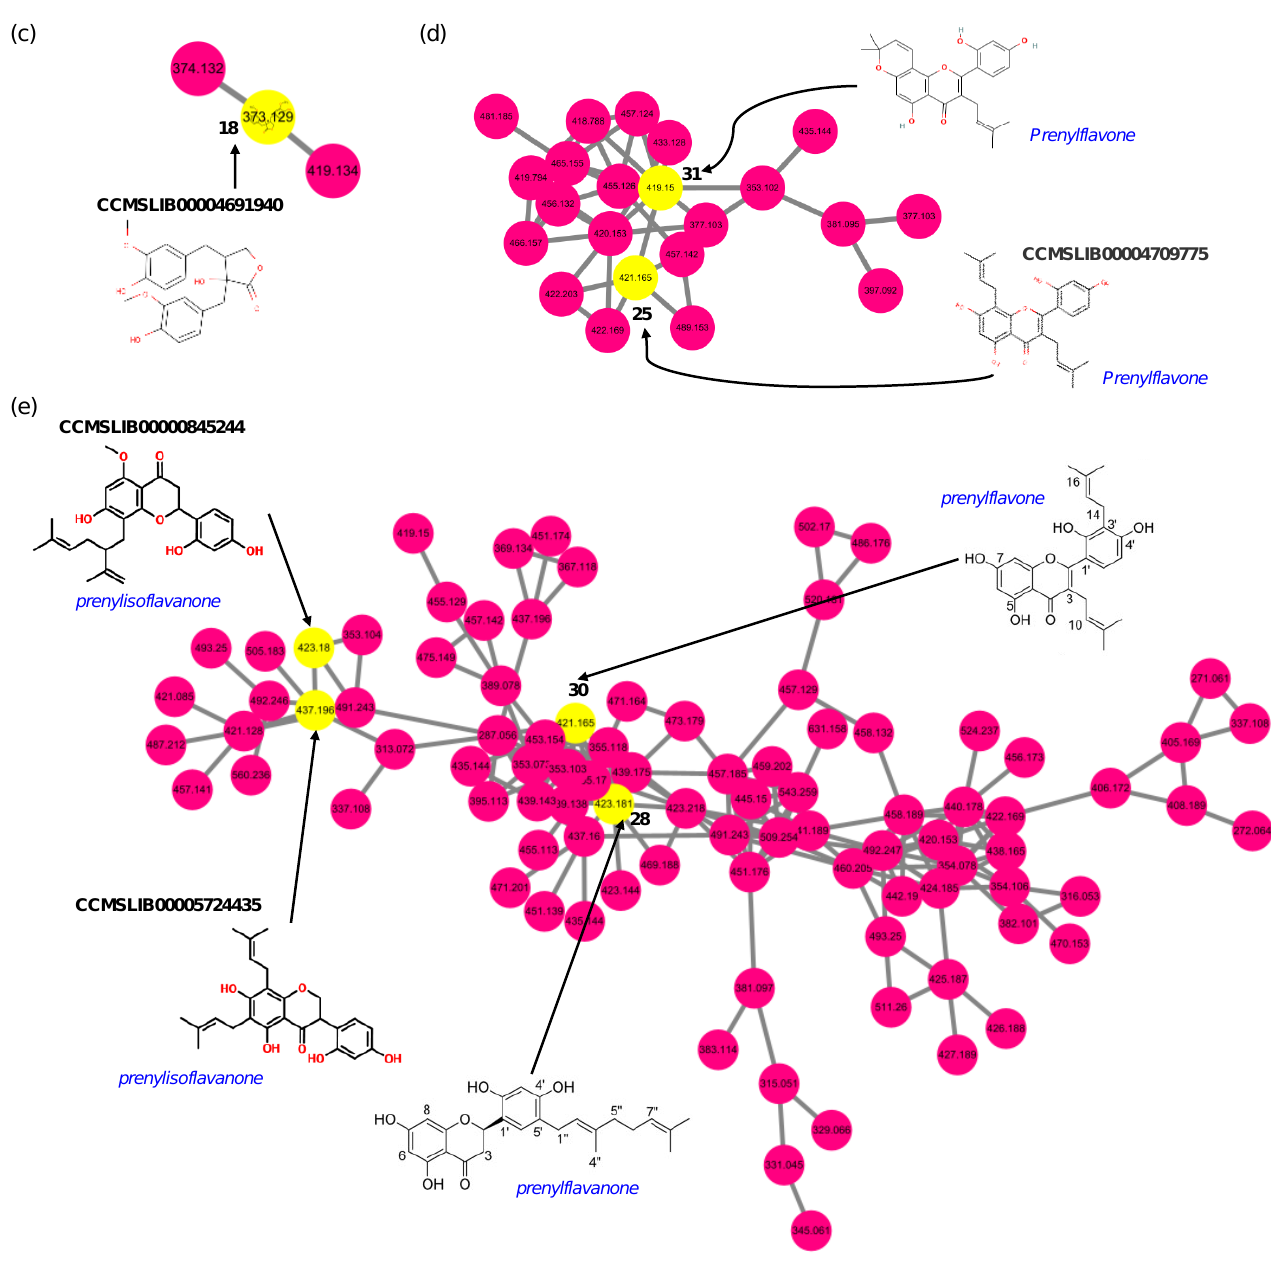
Figure 7. The representative MS/MS spectral network of identified phytochemical compounds in PSY extracts. Spectral nodes indicating identified compounds are noted with numbers (yellow nodes with peak numbers in Table 1). Annotated candidates for selected spectral nodes (yellow nodes without numbers) show compound name, GNPS library spectrum matching (in bold), and chemical class and subclass (in italic with blue). Molecular networks of representative chemical classes or biosynthetic pathways of natural products in PSY extracts. ( a ) iridoid class, ( b ) shikimate pathway including cinnamic (or quinic) acid derivatives, iridoid, furofuranoid lignan subclass in lignan, and stilbene class, ( c ) lignan class, ( d ) prenylflavone subclass in prenylflavonoid class, and ( e ) prenylisoflavanone, prenylflavanone, and prenylflavone subclasses in prenylflanoid class. Further information can be found at the GNPS job link (https://gnps.ucsd.edu/ProteoSAFe/status.jsp?task=e4406e69e619467b9 a347a905d6c383a accessed on 31 March